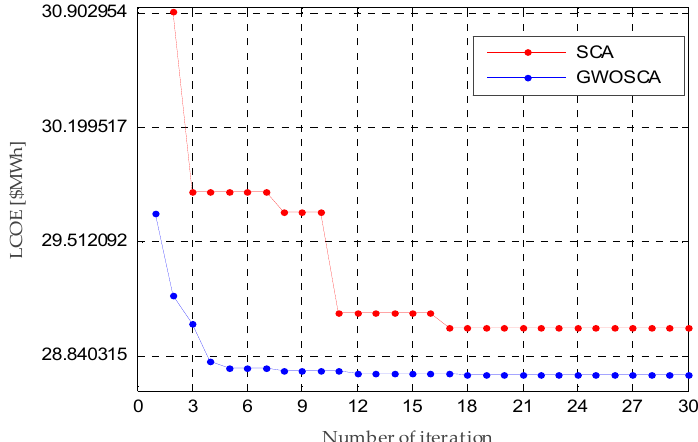
Figure 13. The convergence of the optimisation of LCOE using HGWOSCA algorithm for semi-hourly data.